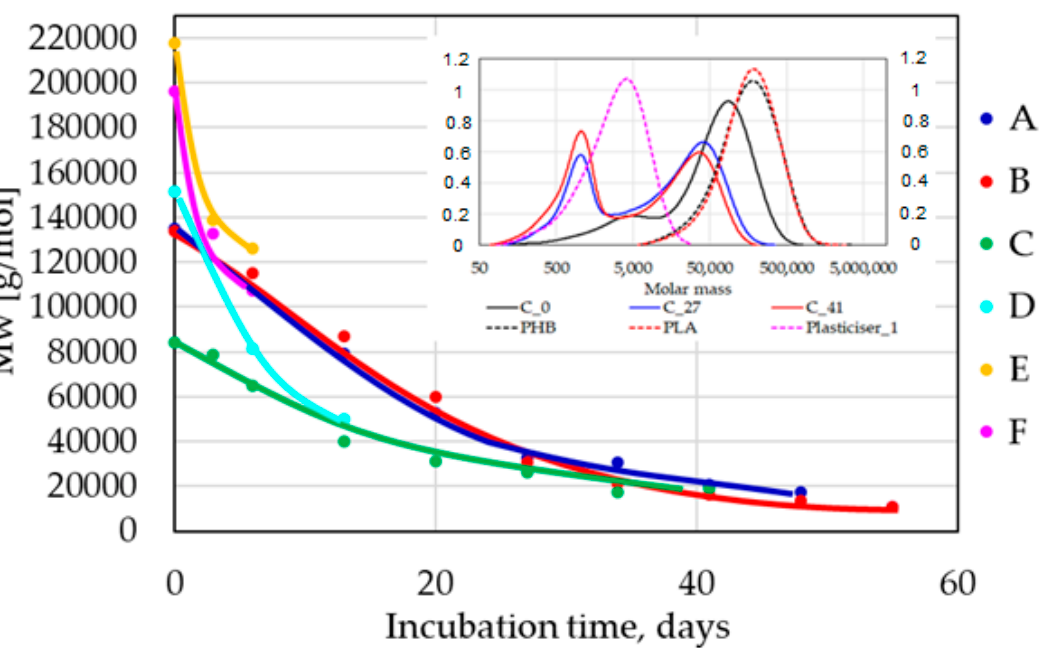
Figure 14. MW evolution during incubation in an electric composter. The GPC records of sample C after 0, 27, and 41 days of composting are shown as an example (insert).